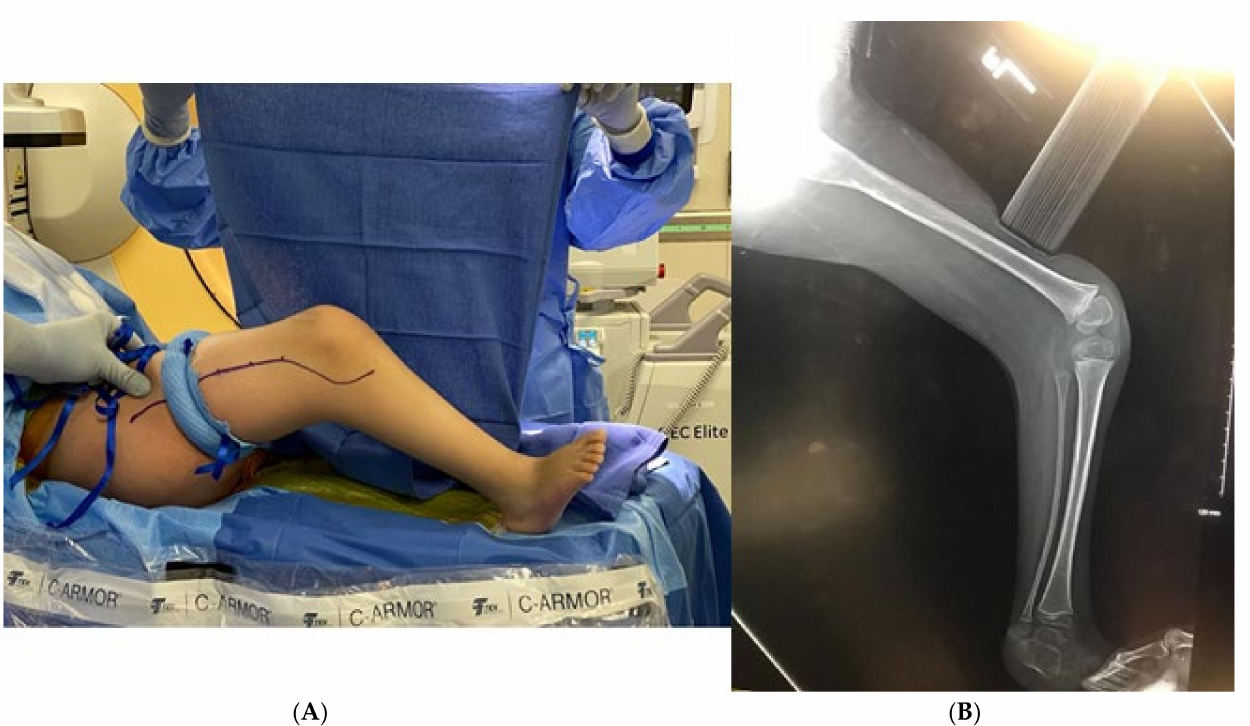
Figure 1. ( A ) Example of incision placement on the lateral thigh. ( B ) Maximum extension radiograph demonstrating 70 ◦ knee flexion